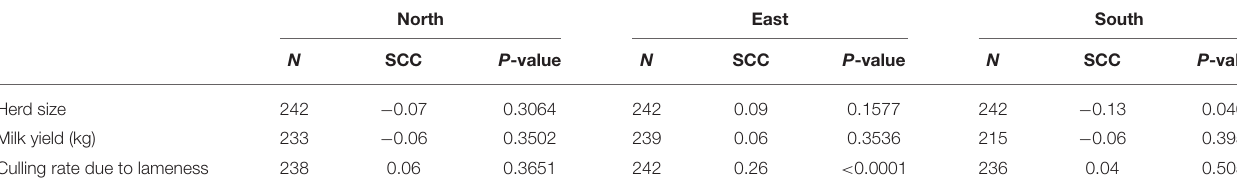
TABLE 4 | Spearman’s correlation analyses: Farmers’ Detection Index and farm characteristics (quantitative